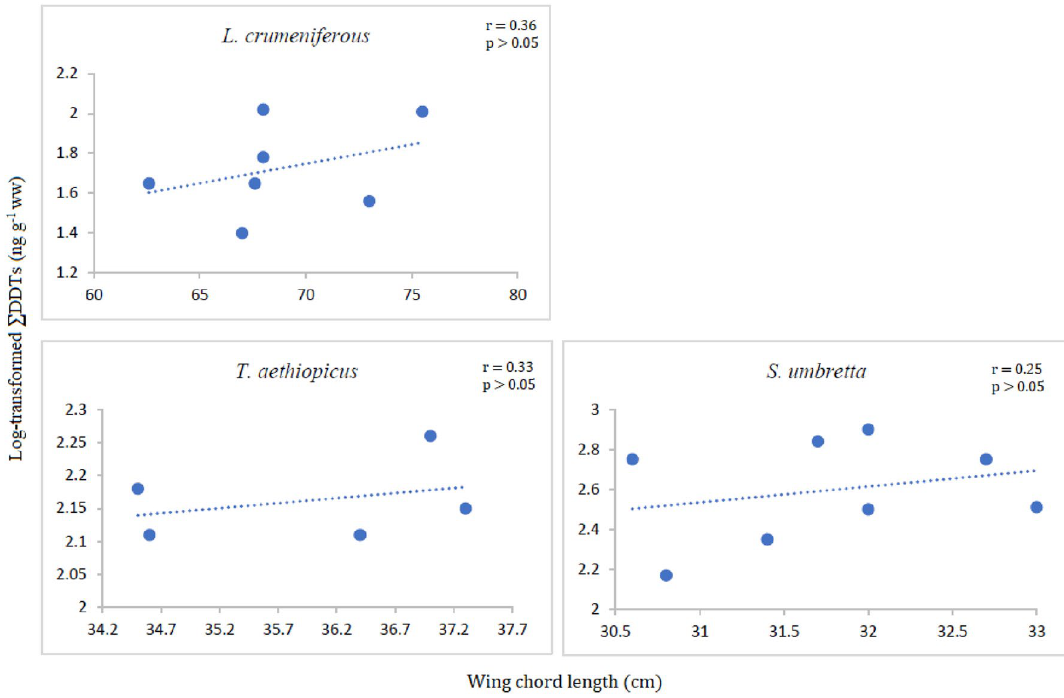
Fig. 2 Association between log-transformed ∑DDTs (ng g −1 ww) and wing chord length